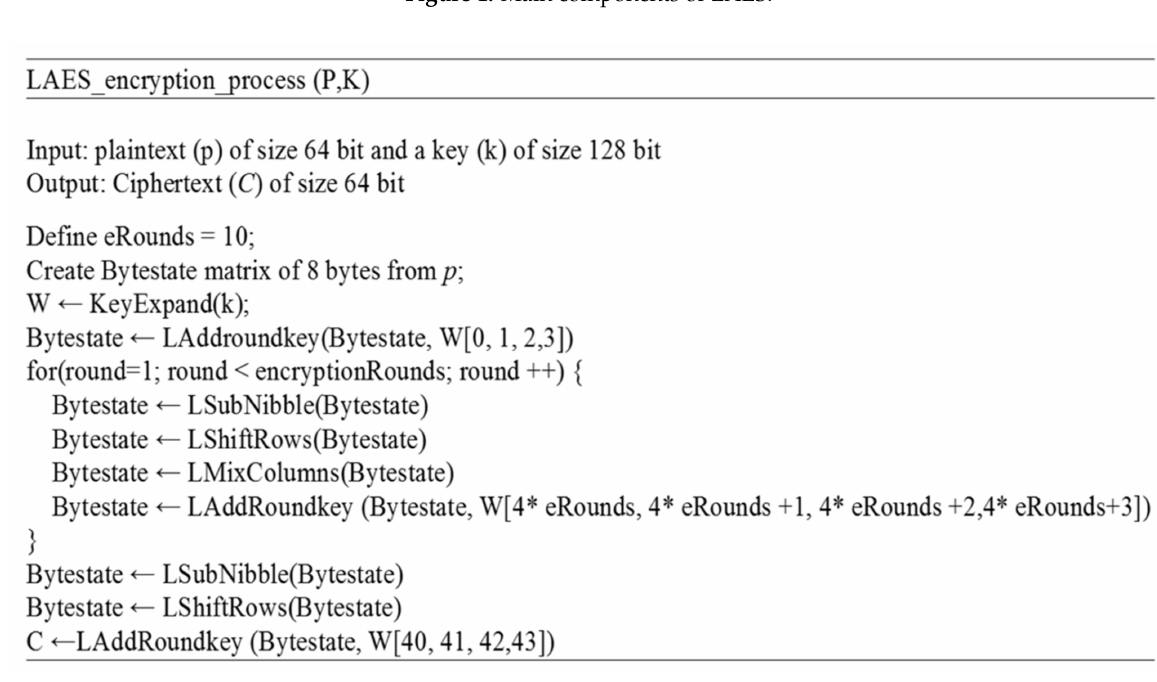
Figure 1. Main components of LAES.